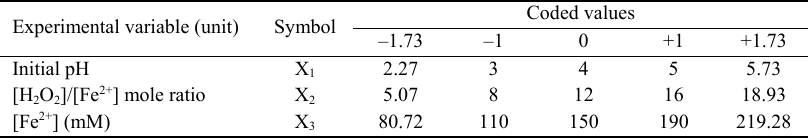
Table 2: Designed values of variables in designed experiments.